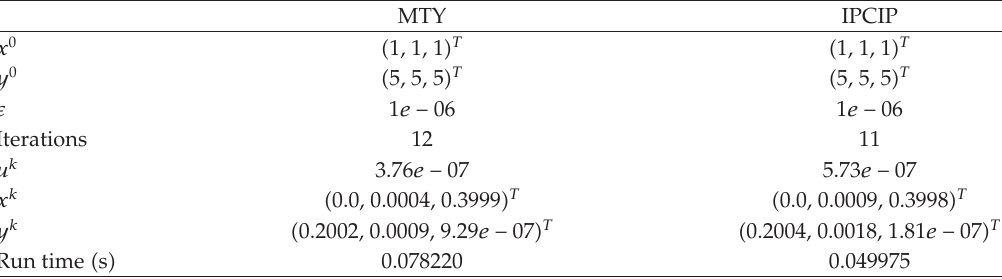
Table 1: Computational results of test problem 1.